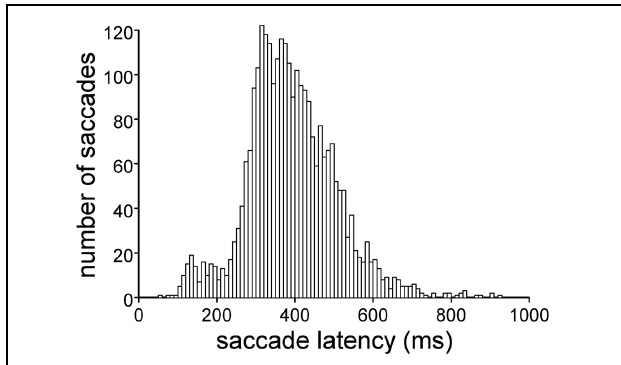
FIGURE 2 | Distribution of saccade latencies in the ‘go’ trials. Execution of the double-choice discrimination task affects the ocular responses, which show long latencies and large